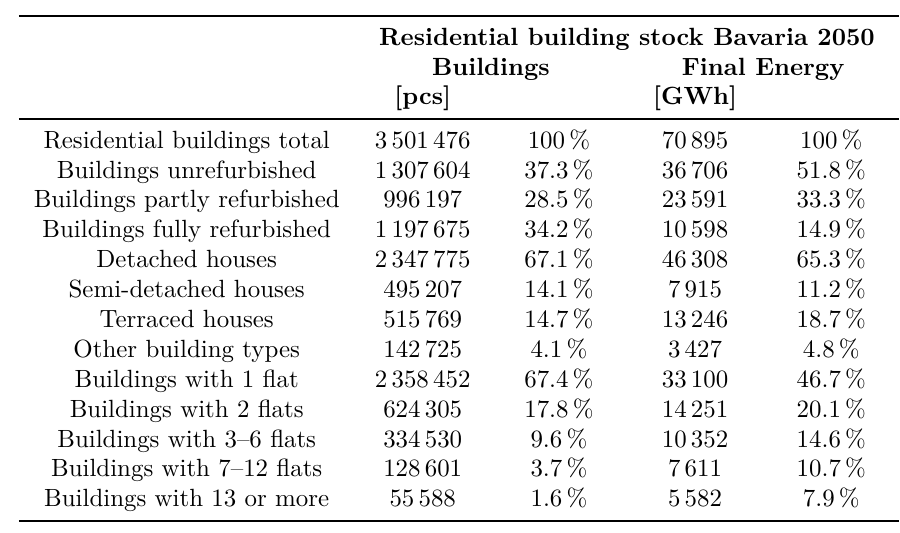
Table 1. Rough summary of the results for the composition of the Bavarian building stock and its energy demand for heating supply. The data for 2050 shows the scenario “rate of refurbishment enhanced”.